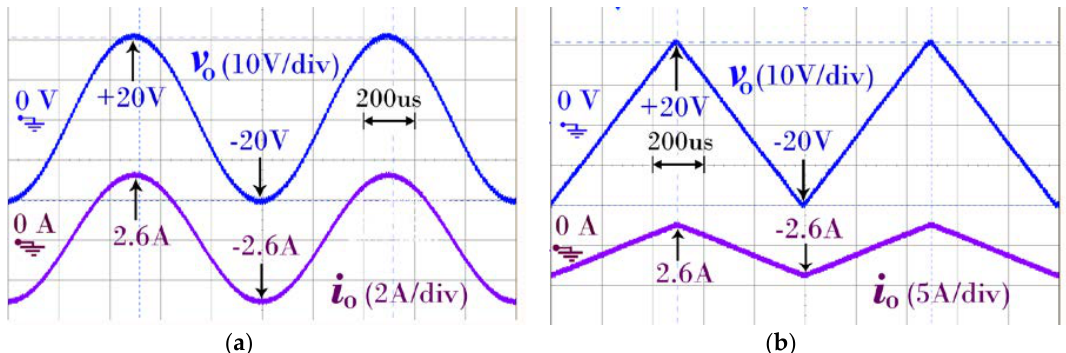
Figure 13. ( a ) Experimental result of GaN class-D amplifier with FFDISM controller output voltage v o and load current i o and ( b ) output voltage v o for reference sine wave v ref . Energies 2018 , 9 , x FOR PEER REVIEW